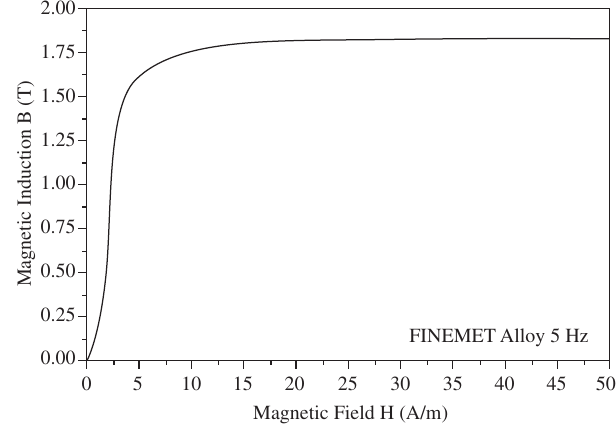
capsule of non-magnetic material that envolves the core FINEMET ® FT-3M F6045G. The domain of study divided in the finite elements of the mesh is shown in Figure